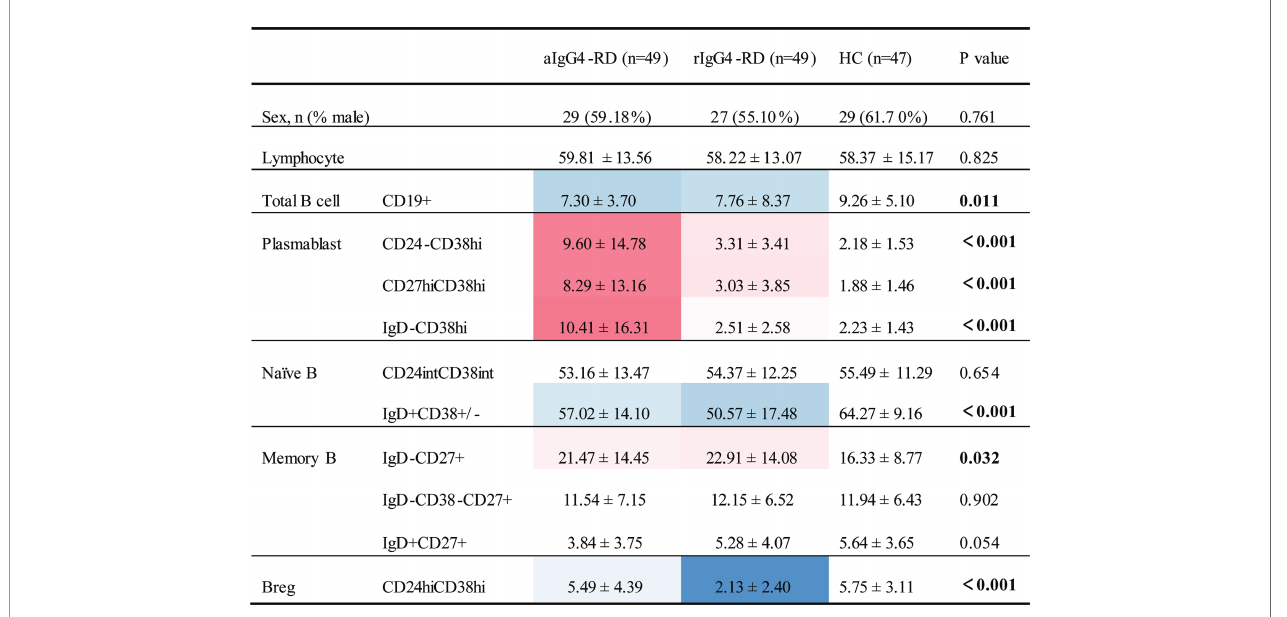
FIGURE 2 | Differences in phenotypes of B- cell subsets among patients with IgG4-RD and age- and sex-matched healthy control subjects. Values that were signi fi cantly different in the patient group compared with the healthy control group highlighted in color (blue for decreased; red for increased). aIgG4-RD, active IgG4- RD; rIgG4-RD, remission